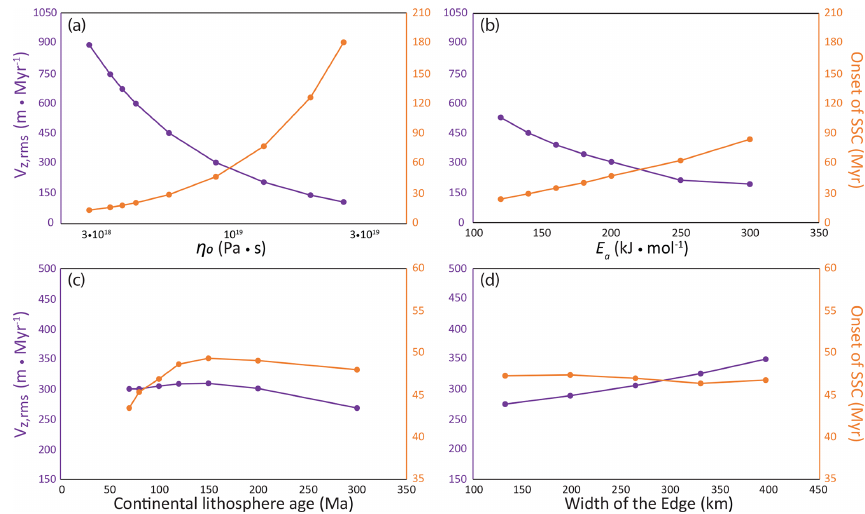
Figure 5. Diagrams showing the sensitivities of v z, rms (root mean square of vertical velocities) and of the onset age of small-scale convection (starting from an oceanic crust of age 40Ma, which needs to be added to the values in the figure) to selected parameters. (a) Reference viscosity ( η 0 ). (b) Activation energy ( E a ). (c) Age (or thickness) of the continental lithosphere ( τ c ). (d) Width in the horizontal direction of the edge ( w ). Note that the vertical axes of (c) and (d) are exaggerated with respect to those of (a) and (b) .